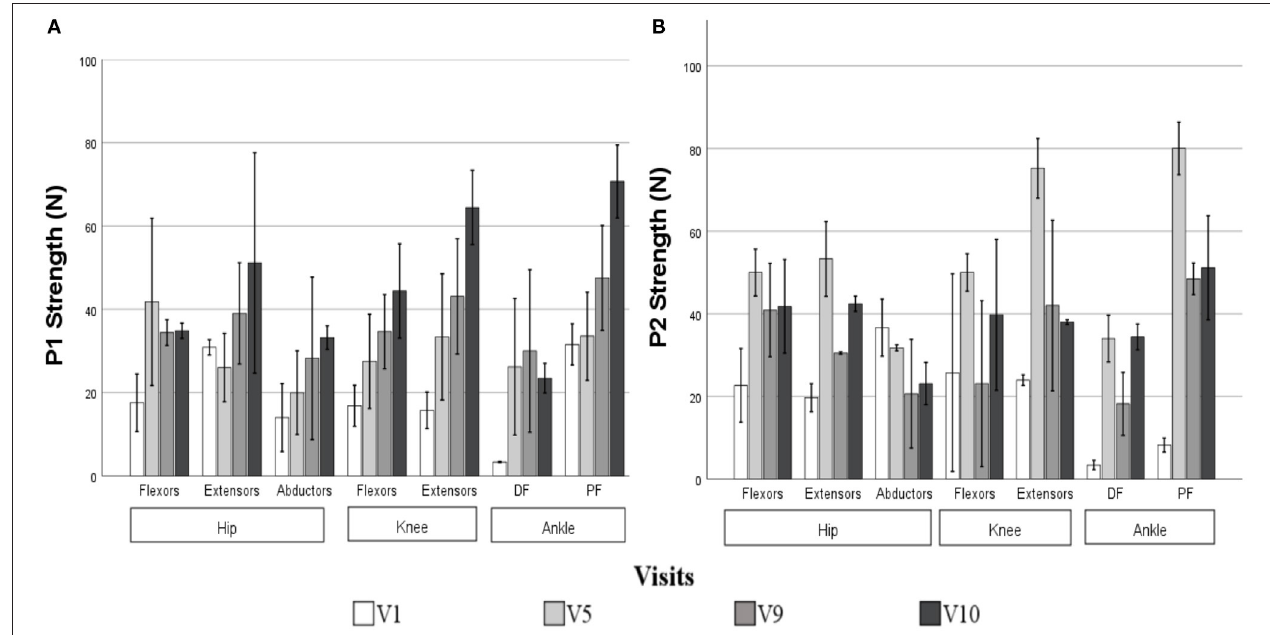
FIGURE 2 | Strength measurements collected for patient 1 (A) and 2 (B) for the different movements assessed in the control visits measured with a Hand-Held Dynamometer in Newtons. Error bars at 95 % CI show a standard deviation of the data. DF, Dorsiflexion; PF, Plantarflexion.